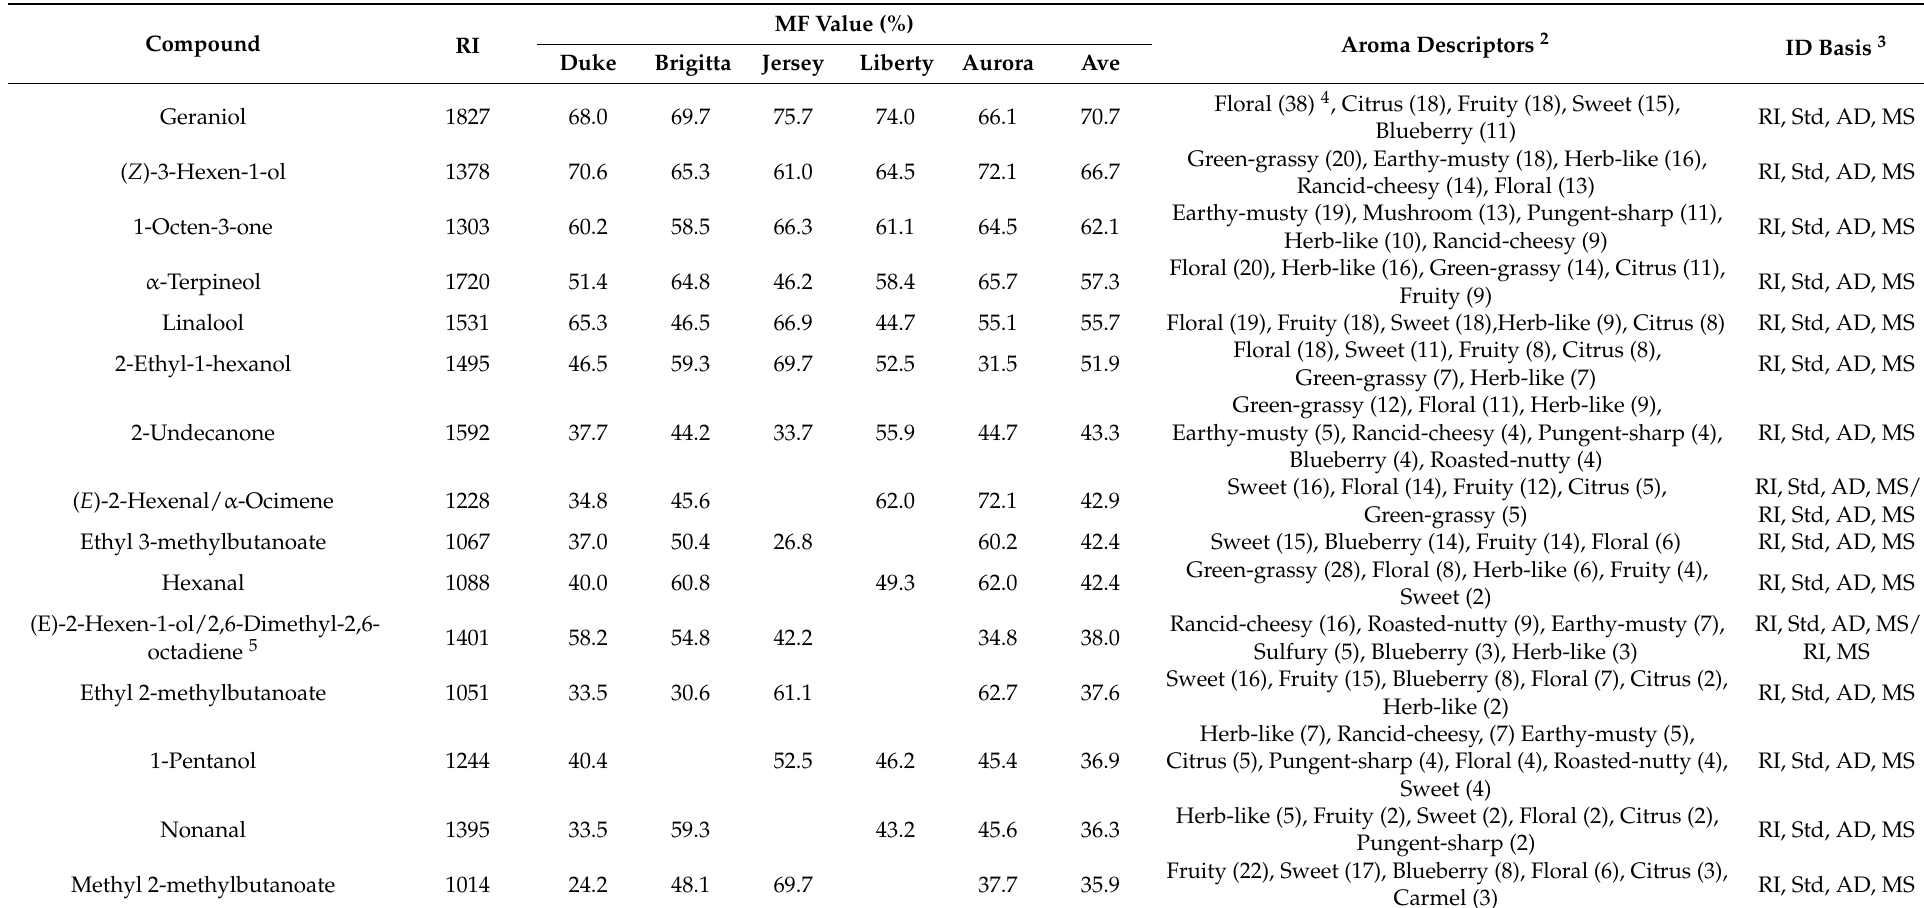
Table 3. Aroma-active compounds in cultivated highbush blueberry fruit of the cultivars ‘Duke’, ‘Brigitta’, ‘Jersey’, ‘Liberty’ and ‘Aurora’ identified through